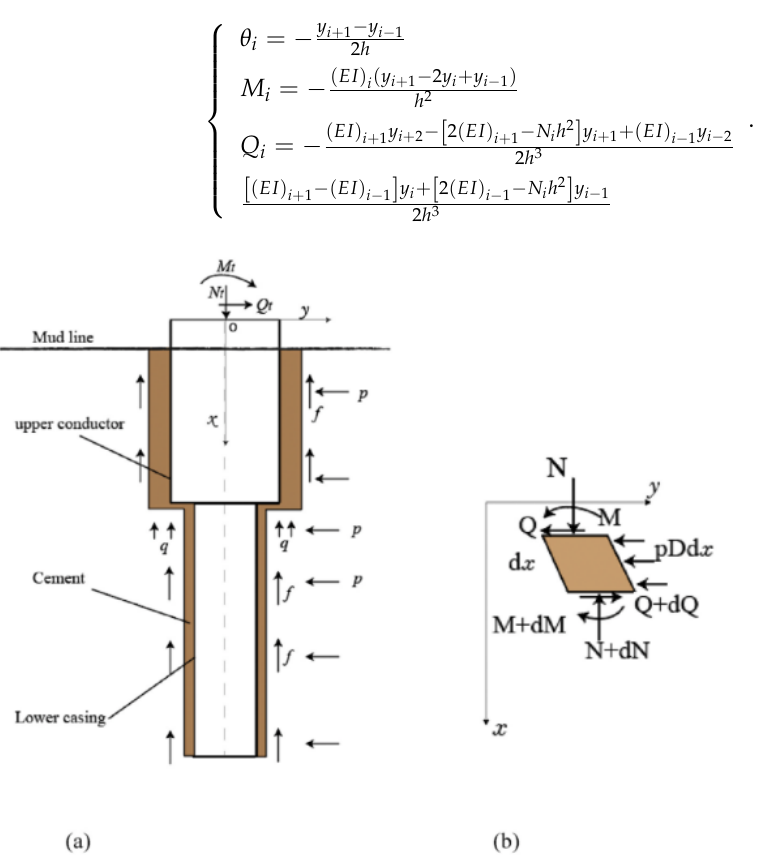
Figure 10. Mechanical analysis diagram of composite casing–cement structure [This figure was modified with permission from ref. [152]. Copyright 2020, Elsevier].